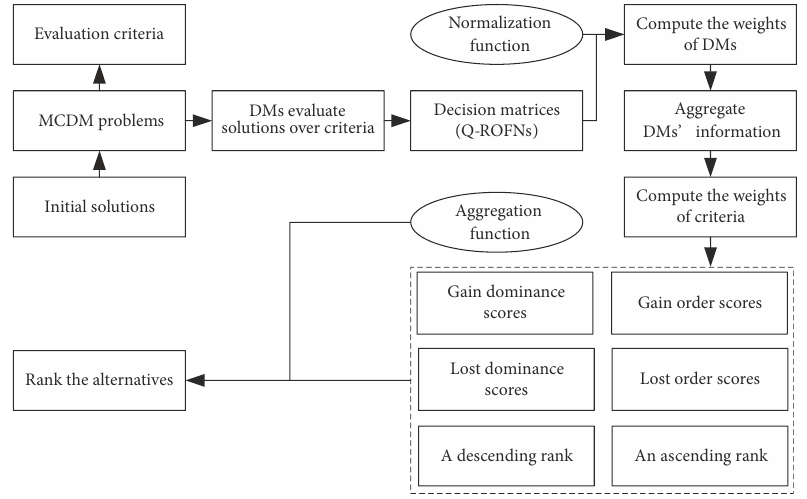
Figure 1. The flowchart of the q-R-GLDS method for MCDM